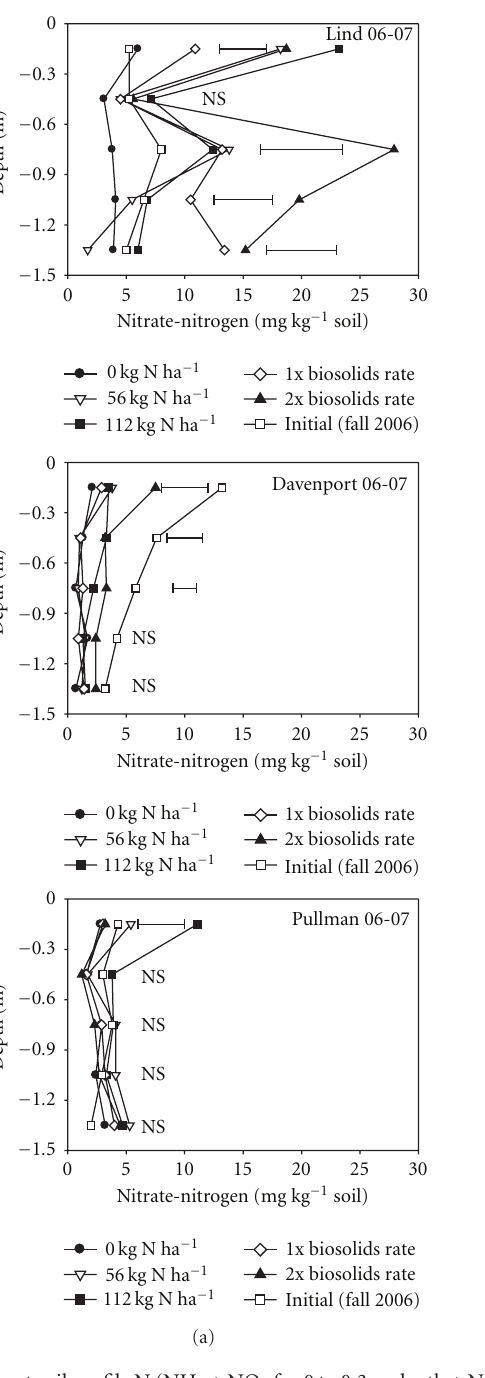
Figure 3: Postharvest soil profile N (NH 4 + NO 3 for 0 to 0.3m depth + NO 3 only 0.3 to 1.5m depth) for the hard red winter wheat treatments from the Lind, Davenport, and Pullman study locations in 2006-2007 (a) and 2007-2008 (b). Error bars represent Least Significant Di ff erence (LSD) values at the 5% level. NS: no significant di ff erence in NO 3 -N concentration among treatments for that sampling depth. Note that inorganic N rates were the same for all site-years except Pullman 2007-2008, where N rates were higher. This is reflected in the di ff erent legend for that